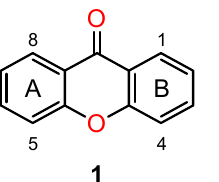
Figure 6. The basic scaffold of the xanthone class of